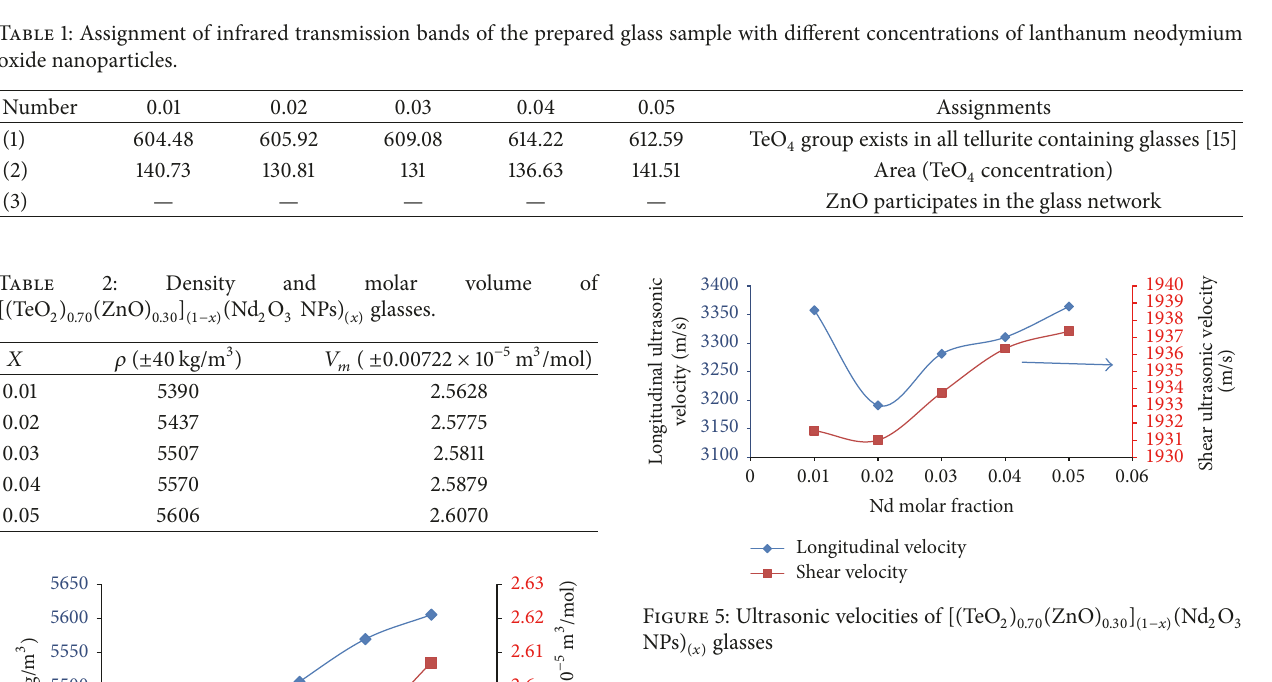
The increasing in the molar volume with the increase in Nd 2 O 3 concentration (Table 2) is attributed to the increase in the amount of nonbridging oxygen (NBO). The neodymium oxide in the glass network acts as a modifier by occupying the interstitial space in the network and creating more NBO in the structure. Thus, the addition of Nd 2 O 3 NPs may even- tually result in an extension of the glass network [26]. After 𝑥 = 0.02 , the increase in the molar volume may be due to the substitution of smaller atoms of Te and Zn in the network with larger atoms of Nd. In the present work, it is shown that the molar volume of the glasses increases with an increase in Nd 2 O 3 NPs concentration. Hence, the increase in molar volume indicates the increasing of free volume in the glass network. This result is consistent with previous work done by Chimalawong et al. (2010) and Zaid et al. (2012) [26,